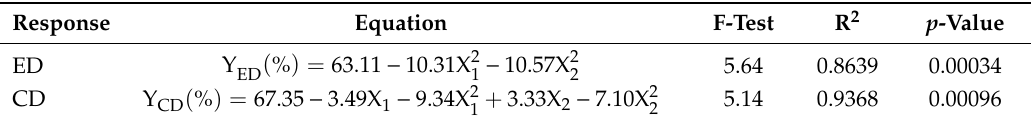
Table 4. Analysis of variance (ANOVA) including models, R 2 , and probability for the final reduced models for the chemical and enzymatic cream